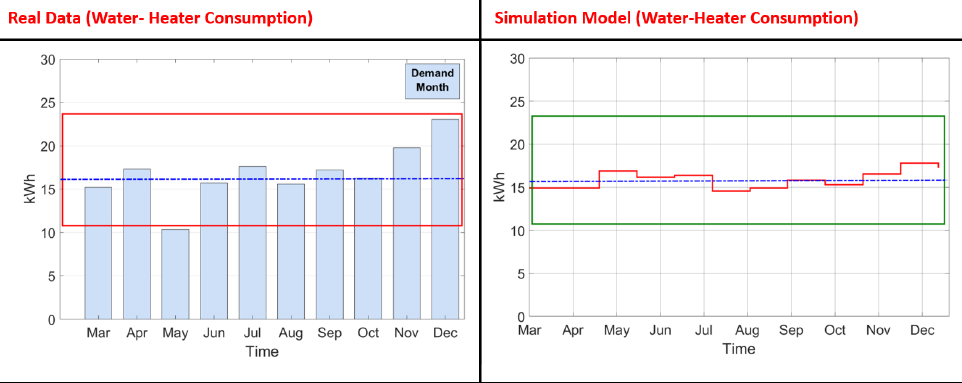
Figure 12. Real data vs. Simulation model